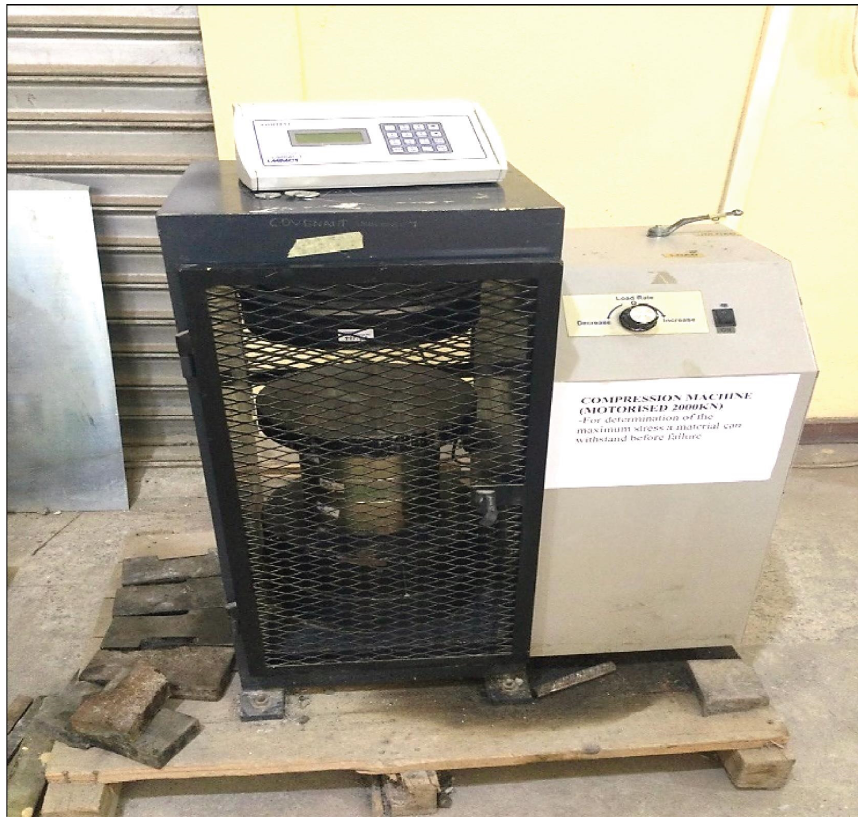
Figure 3: Compressive strength machine.